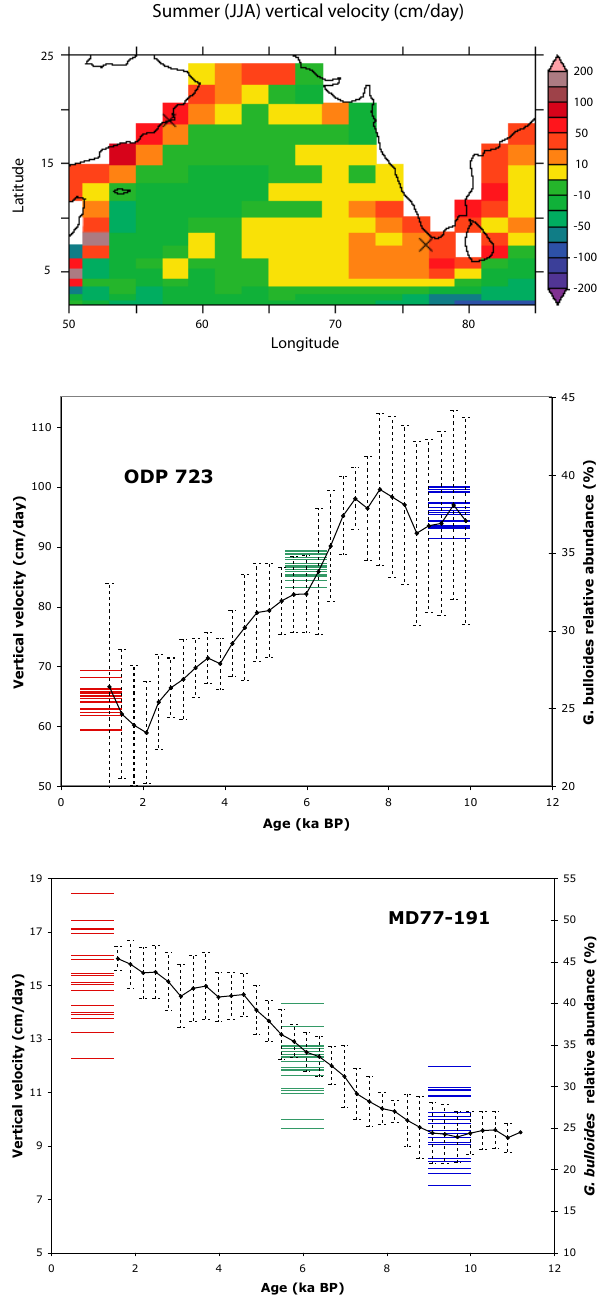
Fig. 7. (A) Map of summer vertical velocity (cmday − 1 ) recon- structed with the IPSL-CM4 model in the control-run simulation. Data/model comparison of upwelling intensity evolution across the Holocene at the locations of Site ODP 723 (B) and core MD77- 191 (C) . G. bulloides data have been re-scaled (0.3 kyr interpola- tion) and smoothed (5-point moving average). Uncertainties are standard deviations estimated over the 5-point windows. Model outputs are mean, vertical velocities estimated at grid-points near the locations of core MD77-191 and ODP Site 723. Black crosses indicate the location of ODP Site 723 and core MD77-191 in the map of panel (A)